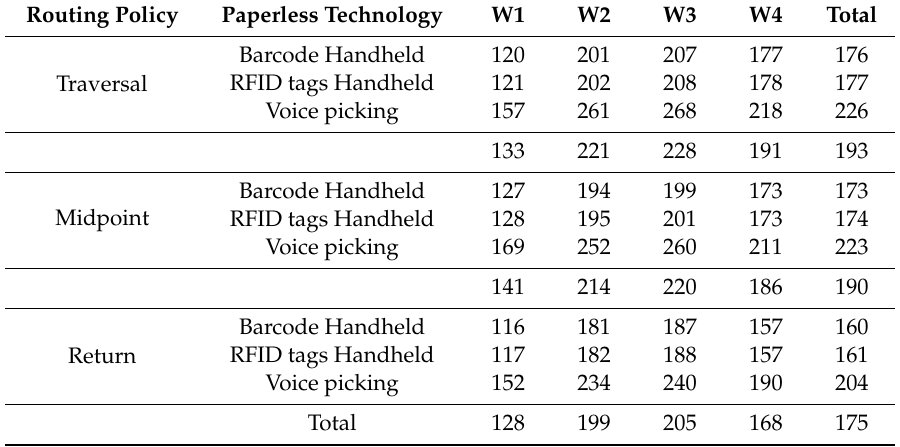
Table 5. The picking rate per hour based on routing heuristics and paperless